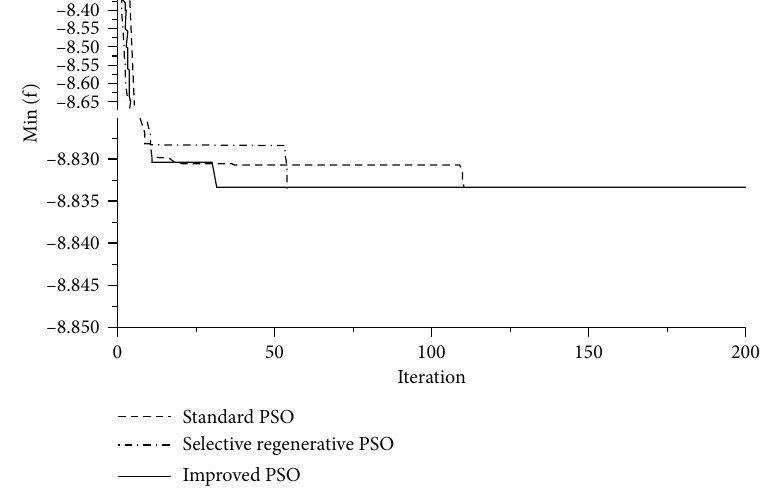
Figure 9: Iterative convergence curve.